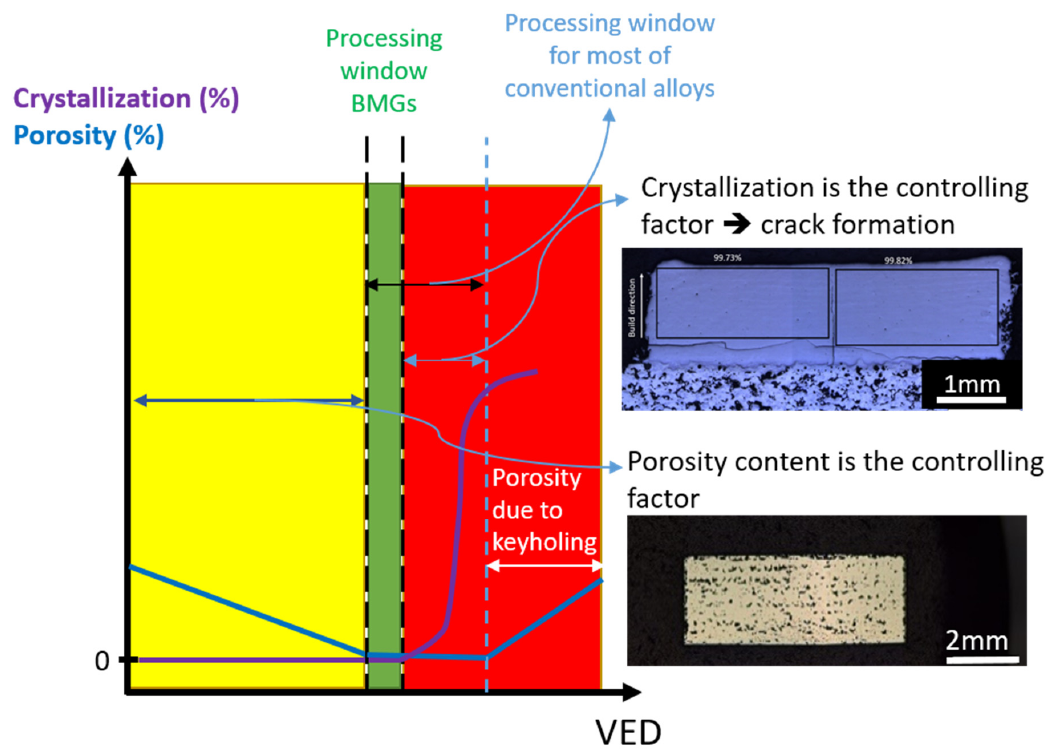
Figure 20. Schematic graph contrasting the AM processing windows of BMGs and conventional crystalline alloys.